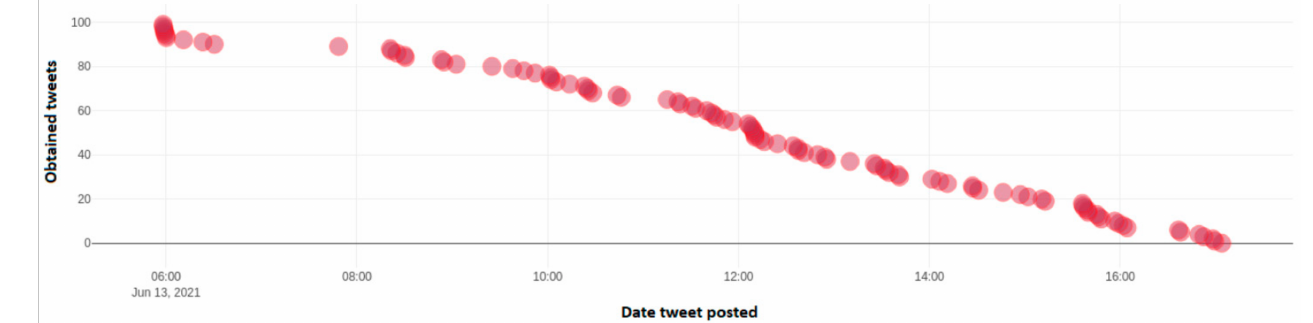
Figure 20. Mined tweets based on negative hashtag (# Σ Υ PIZA_ ξεϕτ ´ ι λε ς ) (100 tweet sample) for SYRIZA party.